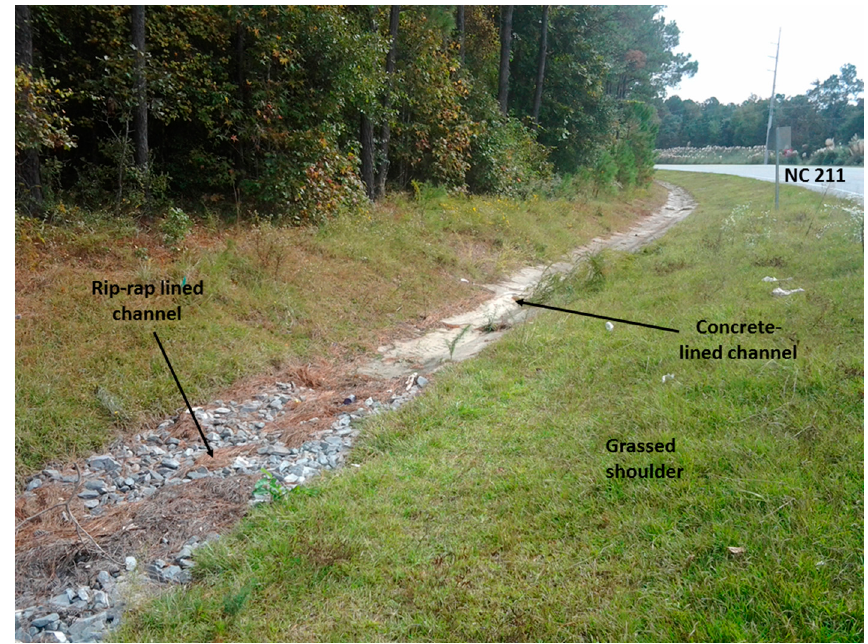
Figure 1. Watershed, grassed shoulder, and concrete-lined channel leading to the forebay of the bioswale.